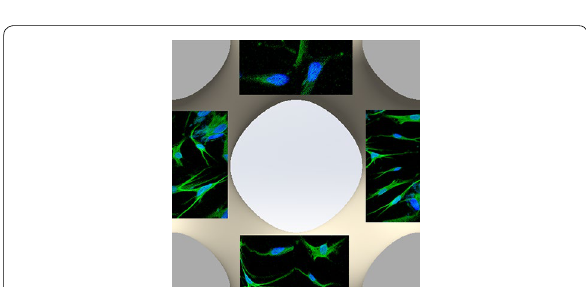
Figure 23 Fluorescence image (assembled with eight images, with the inlet velocity 0.0075 m/s on the 10th